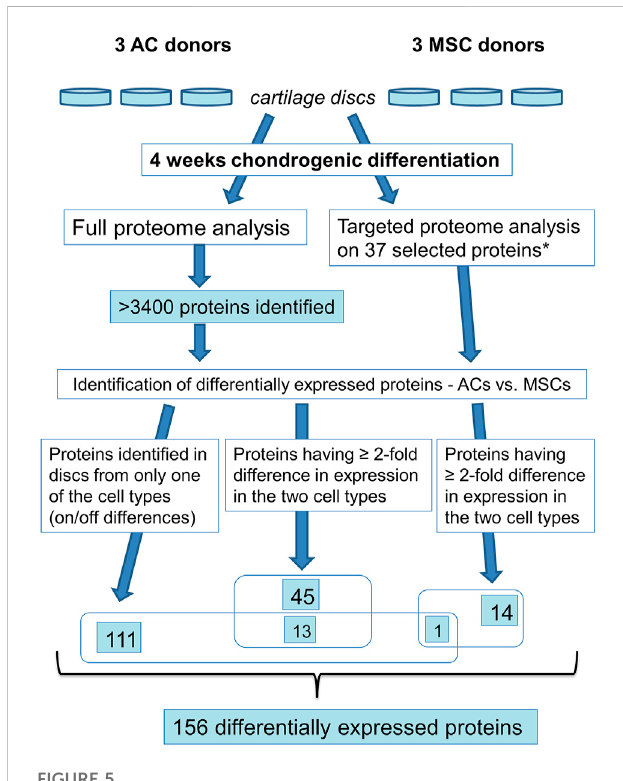
FIGURE 5 Overview of proteomics analysis. * based on the > 3,400 identi fi ed proteins 37 proteins were selected for targeted proteome